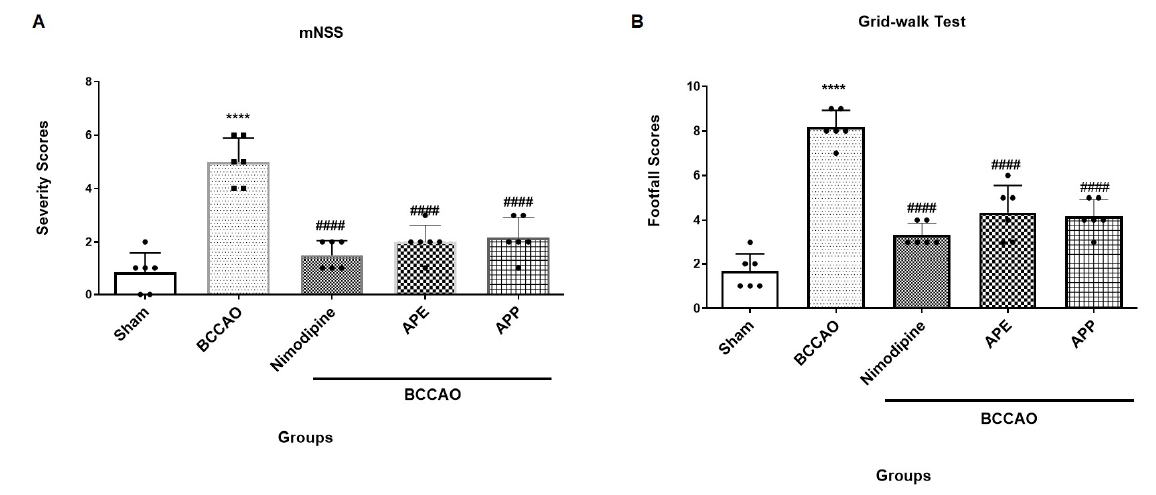
Figure 3. ( A ) Modified neurological severity scores (mNSS). Results are mean ± SD. ( n = 6). **** p < 0.0001 vs. the sham group, #### p < 0.0001 vs. the bilateral common carotid artery occlusion (BCCAO) group. ( B ) Grid-walking test. Results are mean ± SD. Repeated measures one-way analysis of variance with Bonferroni post-hoc was used. **** p < 0.0001 vs. the sham group, #### p < 0.0001 vs. the BCCAO group. Pharmaceuticals 2021 , 14 , x FOR PEER REVIEW 2.3. APP and APE Decreased Brain Tissue Injury in Hematoxylin and Eosin (H and E) Staining As indicated in Figure 4, the H and E assay of brain motor cortex showed that the rat brain from the sham group had normal histology with preserved neurological cells. In the BCCAO group, partial loss of neurological cells with cavity formation was observed. Pre- treatment with APP and APE showed relatively preserved neurological cells with normal histology.